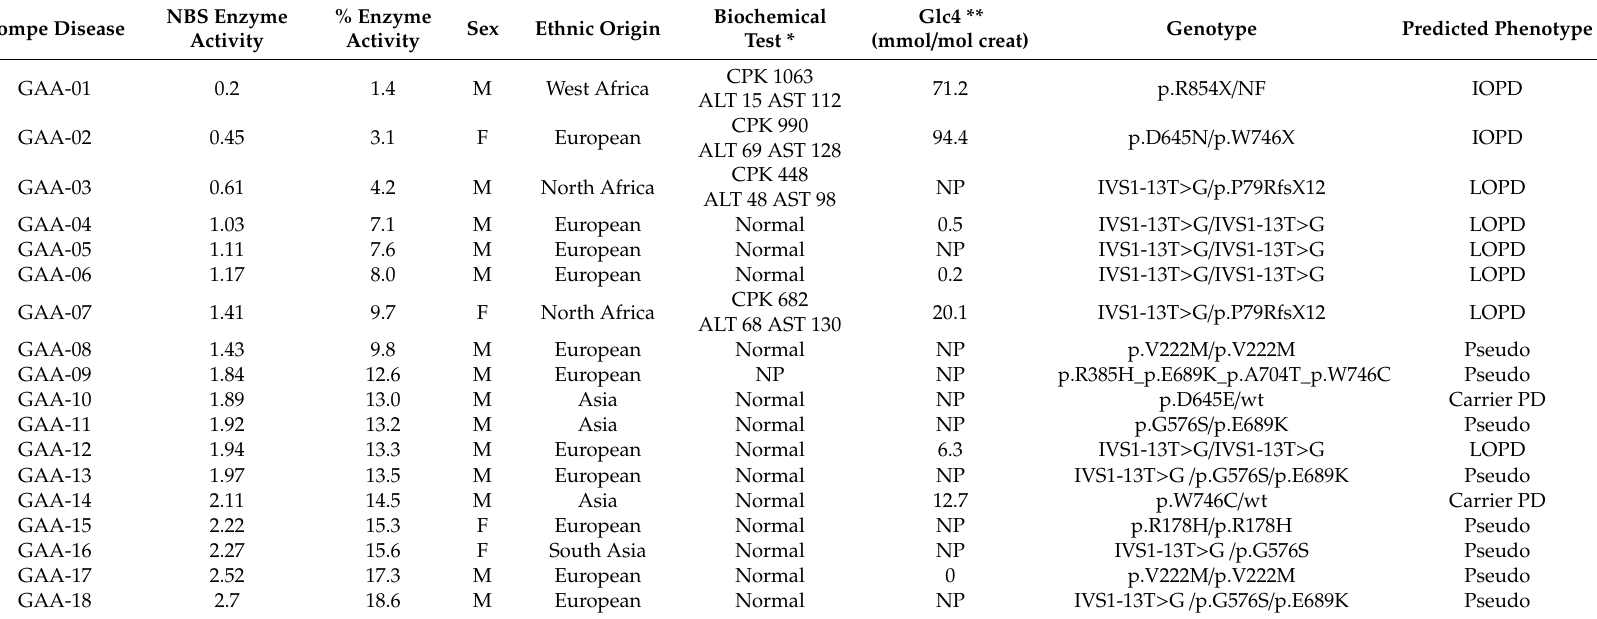
Table 2. NBS enzyme activity, confirmatory testing results and final diagnosis in newborns with suspicion of Pompe Disease. Newborns were ordered based on neonatal screening enzyme